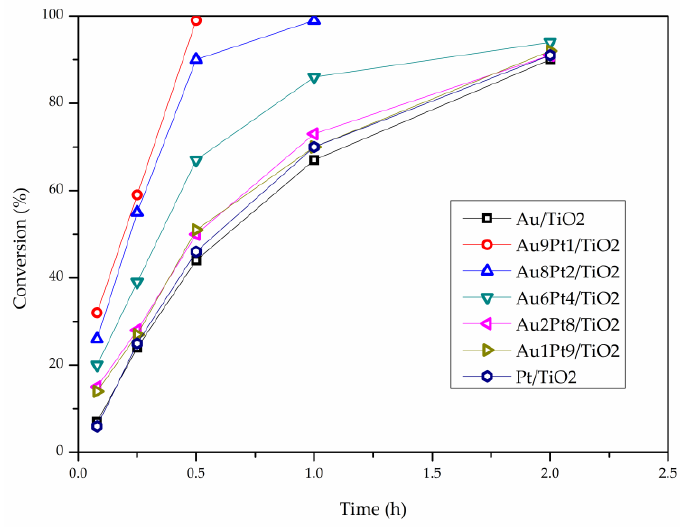
Figure 3. Reaction profile of Au-Pt catalyst in the glycerol oxidation in presence of NaOH.